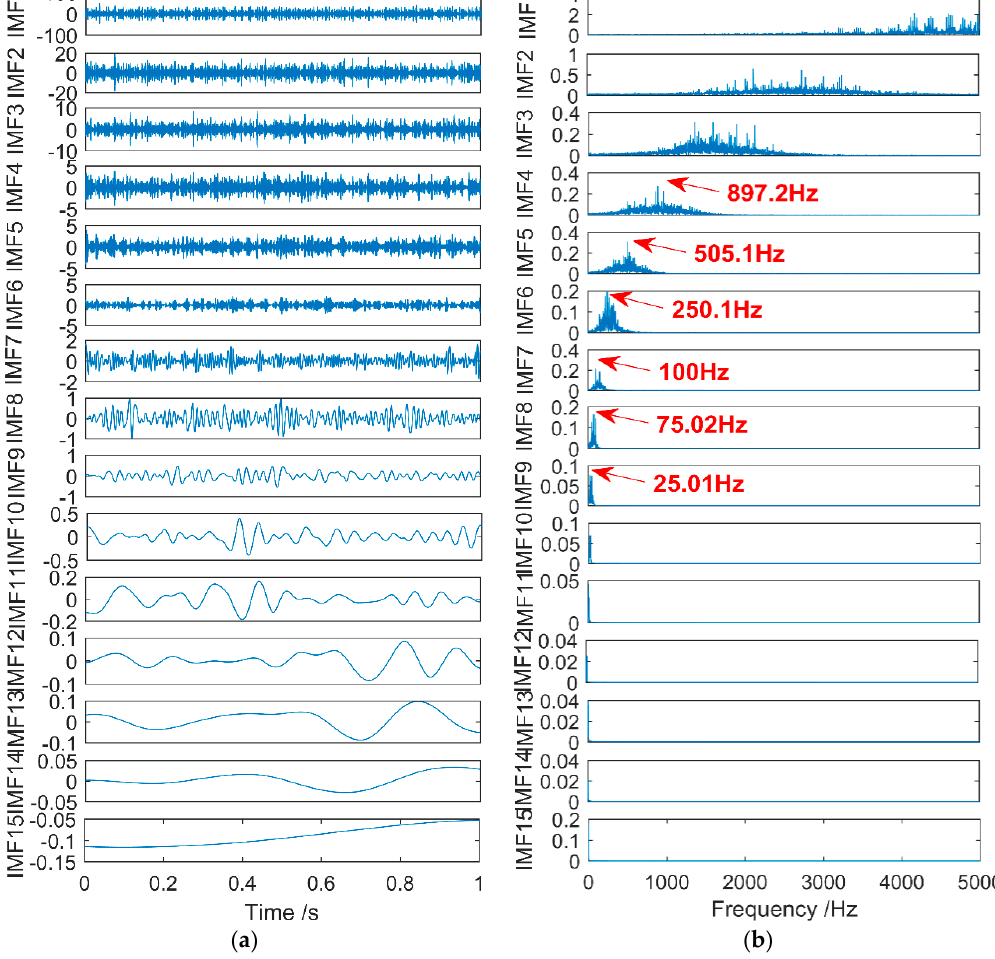
Figure 15. CEEMD decomposes vibration signals. ( a ) Time domain. ( b ) Frequency domain.